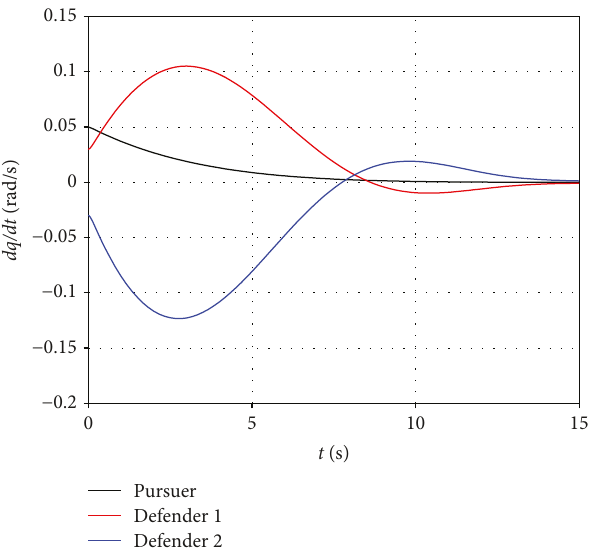
Figure 19: Acceleration variation of Defender 2 (two-side intercept). Table 2: Initial launch parameters of the two Defenders.